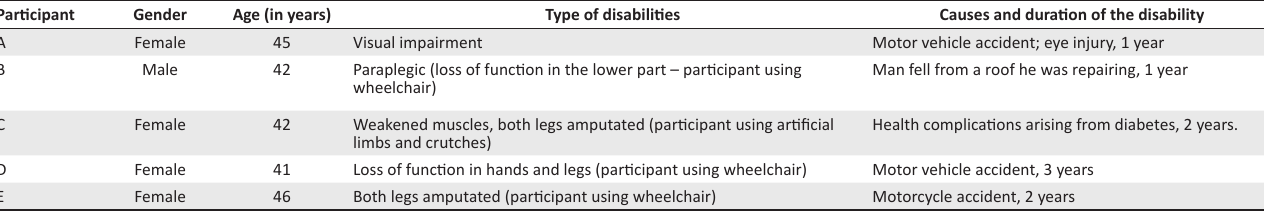
TABLE 1: Participants characteristics ( n = 5).